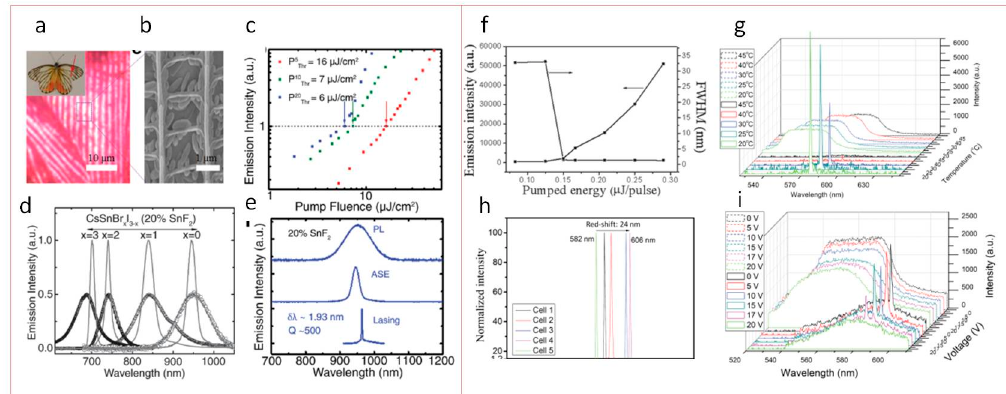
Figure 8. Lasing in lead-free perovskite materials. ( a ) Optical image of a butterfly scale from the white part of the wing. Inset is a photograph of the butterfly. ( b ) SEM image showing lamellae (vertical structures) in the scale. ( c ) Variable fluence measurements reveal the amplified spontaneous emission (ASE) thresholds of the SnF 2 -treated samples. ( d ) Wide PL and ASE wavelength tunability from CsSnBr x I 3 − x films fabricated by facile mixing the precursor solutions under 500 nm pump pulses (50 fs, 1 kHz). ( e ) A comparison of the PL, ASE, and single-mode lasing of CsSnI 3 (20% SnF 2 )